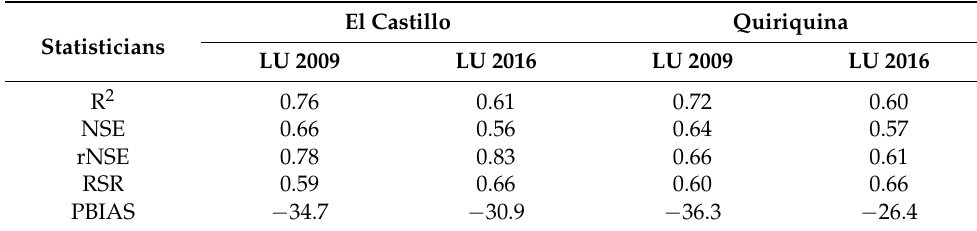
Table 7. Model efficiency criteria under LU 2009 (2006–2009) and LU 2016 (2012) at daily time step for El Castillo and Quiriquina